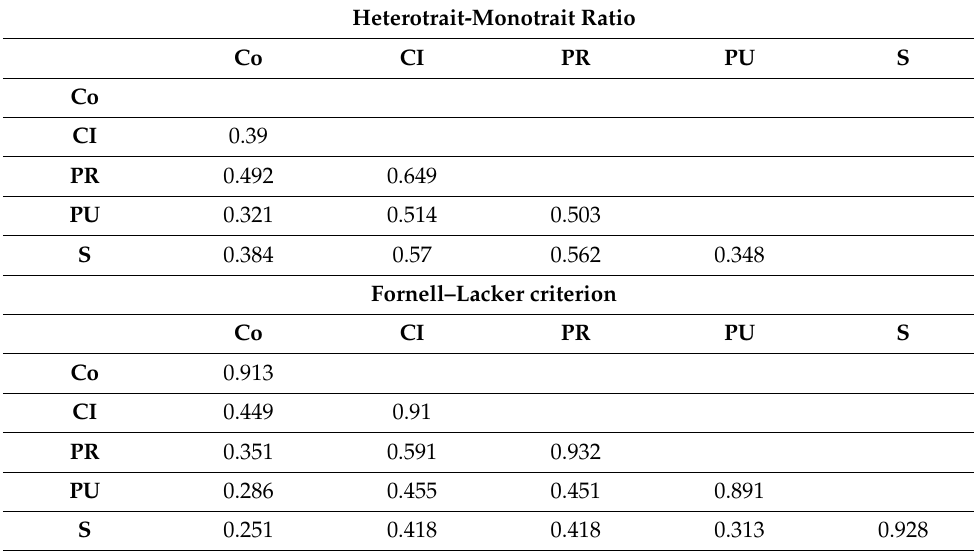
Table 5. Discriminant Validity (HTMT and Fornell–Lacker